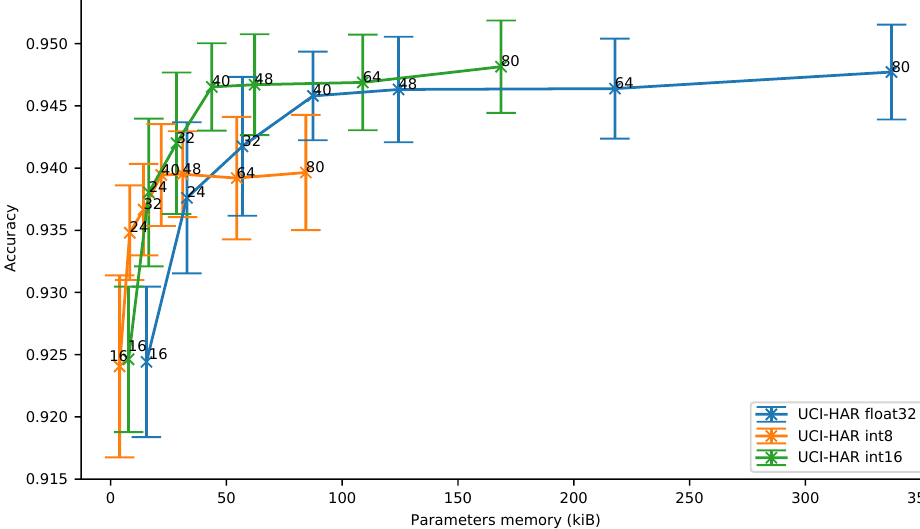
Figure 6. Human Activity Recognition dataset (UCI-HAR): accuracy vs. parameters